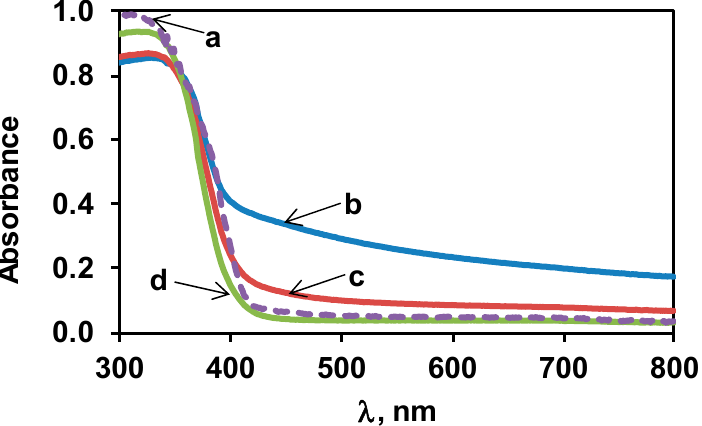
Figure 3. UV-Vis spectra of the bare TiO 2 samples. Line a: P25; line b: sol–gel-prepared and cal- cined at 400 °C (SG400), line c: sol–gel-prepared and calcined at 450 °C (SG450), line d: sol–gel-prepared and calcined at 500 °C